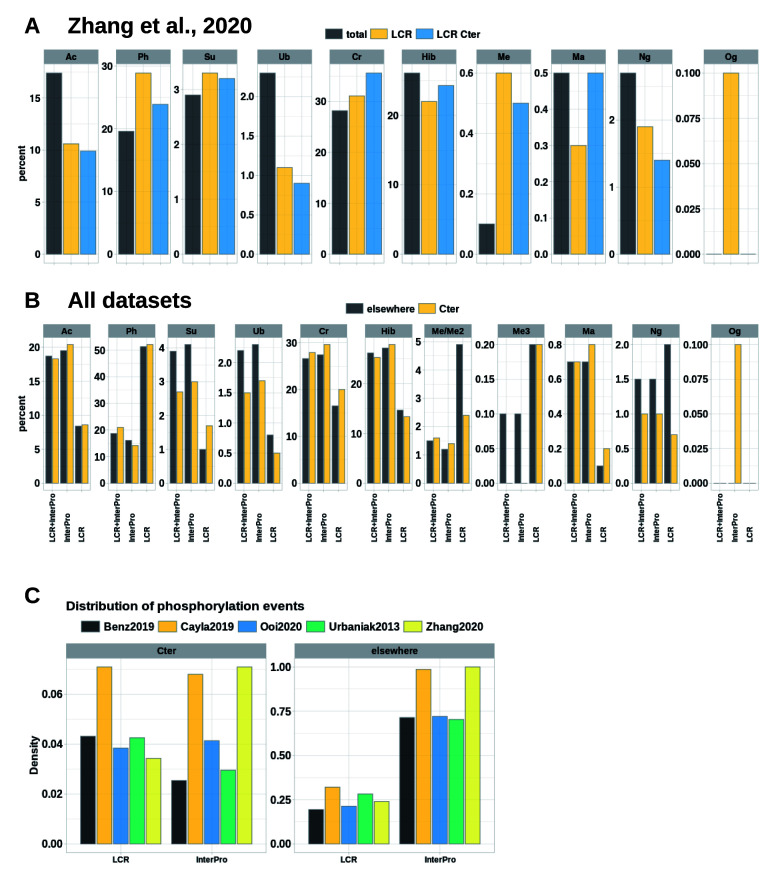
Mapping of post-translational modifications.
A) The relative representation (percent) of post-translational modifications, identified in
T. brucei bloodstream parasites by Zhang
et al.
15, were analysed in the total proteome (grey), in the low-complexity regions (LCRs; yellow) or in the LCRs located in the C-terminal region of their corresponding protein (blue).
B) The Zhang
et al. dataset
15 was merged with those obtained by: Urbaniak
et al., 2013, Benz
et al., 2019, Cayla
et al., 2019, Ooi
et al., 2020 for the analysis of phosphorylation, Fisk
et al., 2013 and Lott
et al., 2013 for the mono/di-methylation and Moretti
et al., 2018 for the lysine acetylation
14–
17,
19–
21,
32; to obtain the positions of all documented modifications. The relative representation (percent) of post-translational modifications was analysed in the InterPro domains + LCRs, InterPro domains only or LCRs only, according to the position within the domain/LCR on which they are located, i.e. C-terminal (yellow) or elsewhere (grey). The distributions of phospho-residues were compared between the different datasets for their position within domains/LCRs, according to the position of the domain/LCR on which they are located: C-terminal or elsewhere.
C) Density distribution of the phosphorylation event from the different datasets.